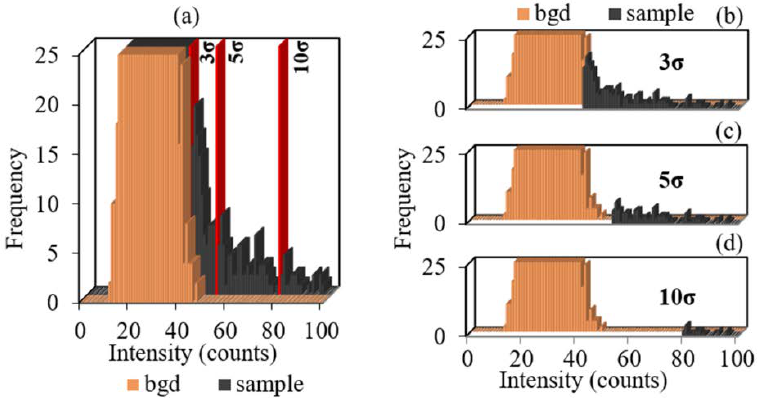
Figure 4. The signal distributions of ( a ) the background and sample 3 and particle distributions after correction by ( b ) 3σ, ( c ) 5σ , and ( d ) 10σ threshold.